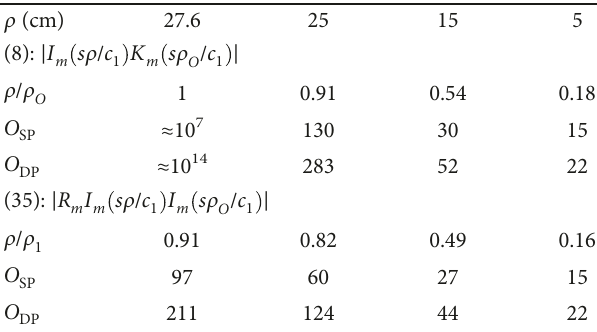
Table 4: The orders m = O and m = O for which the terms in SP DP the series in (8) and (35) have dropped to fractions 10 -7 (single precision) and 10 -14 (double precision), respectively, of their maximum absolute values, for di ff erent ρ .